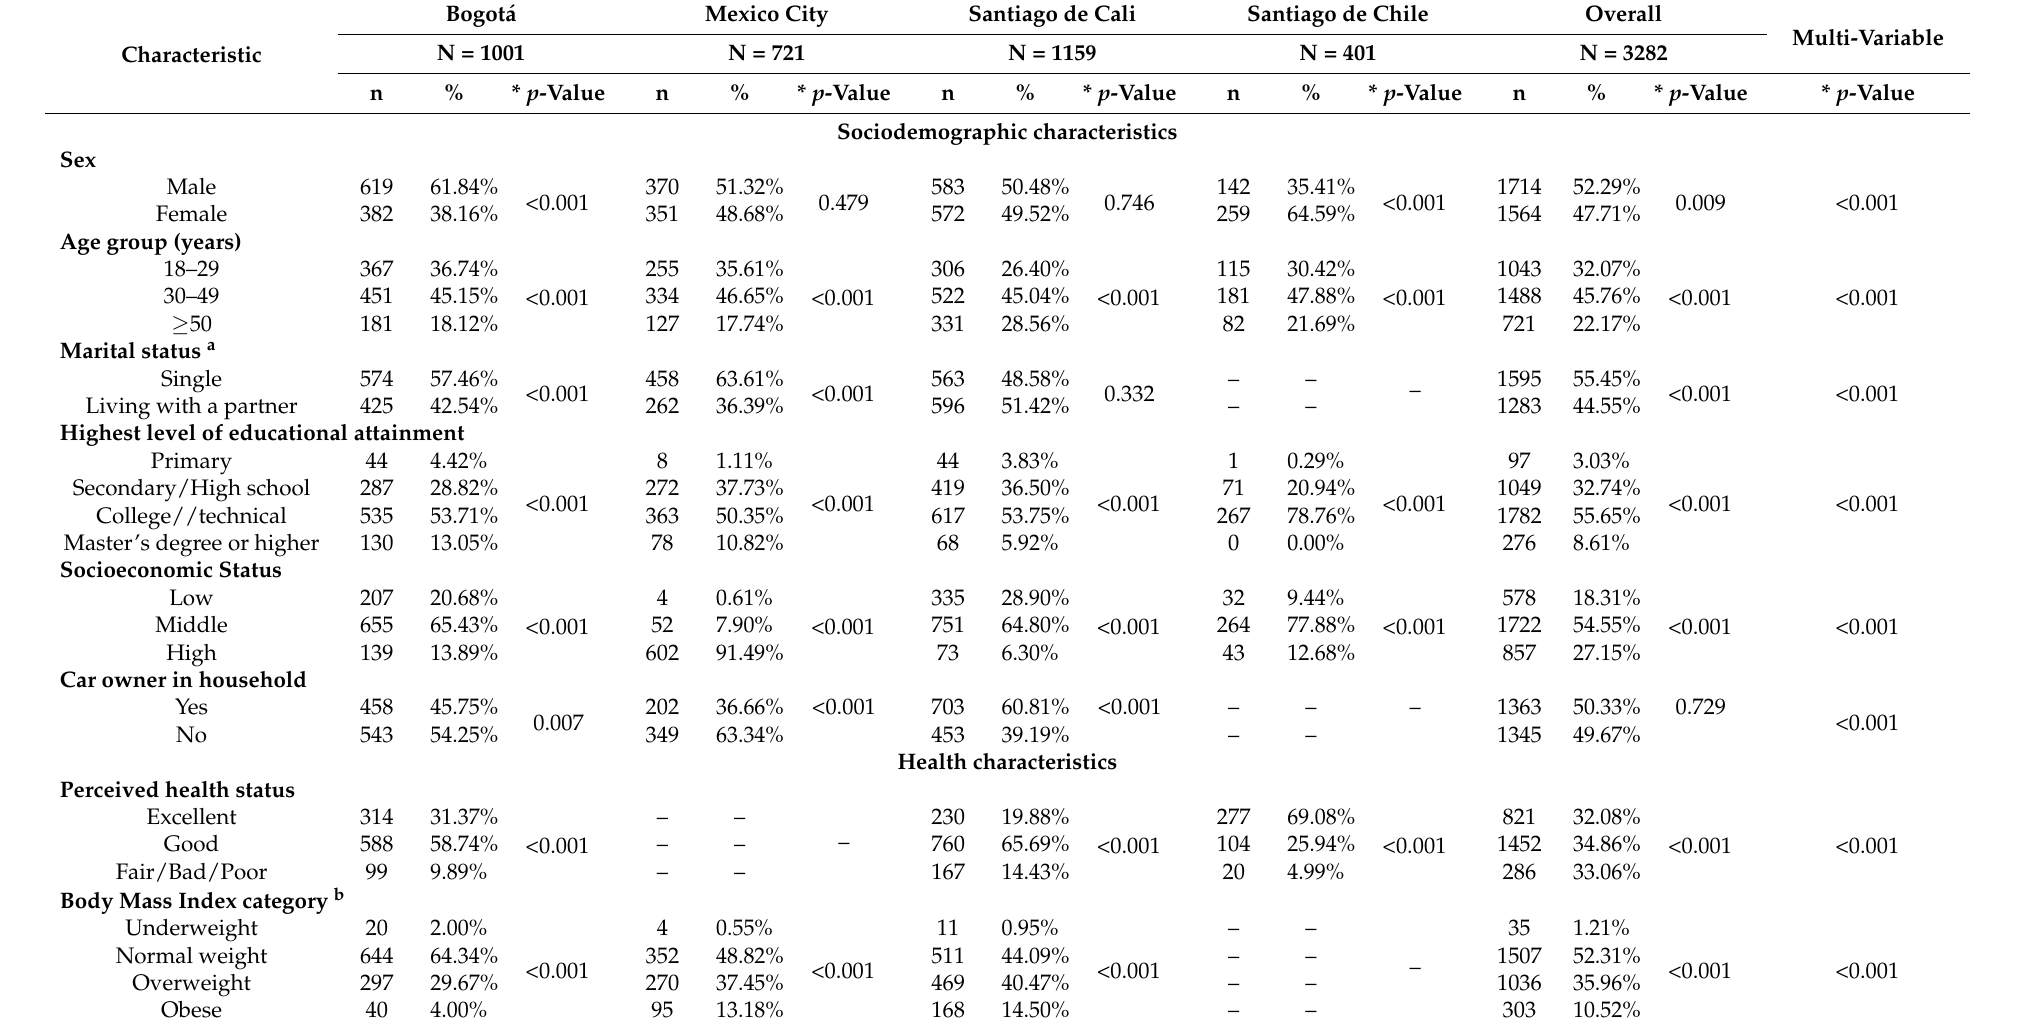
Table 3. Sociodemographic, health, program use and physical activity characteristics of the Ciclov í a Recreativa program participants by study site.